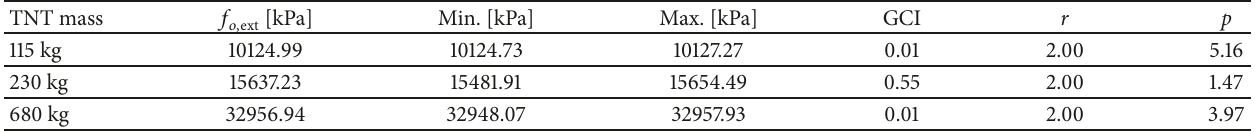
Table 10: Extrapolated overpressure values ( 𝑓 표, ext ) and GCI for 3D